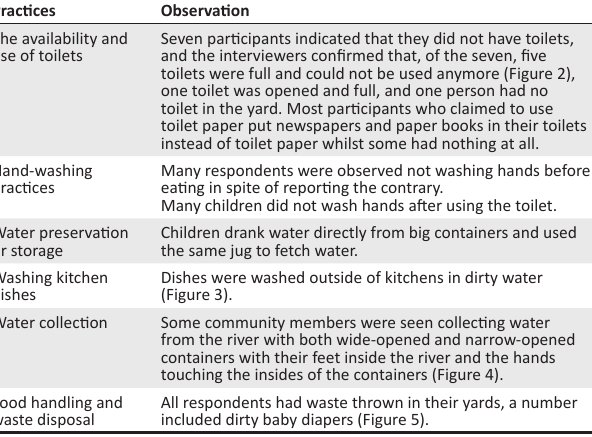
TABLE 7: Summary of interviewers’ general